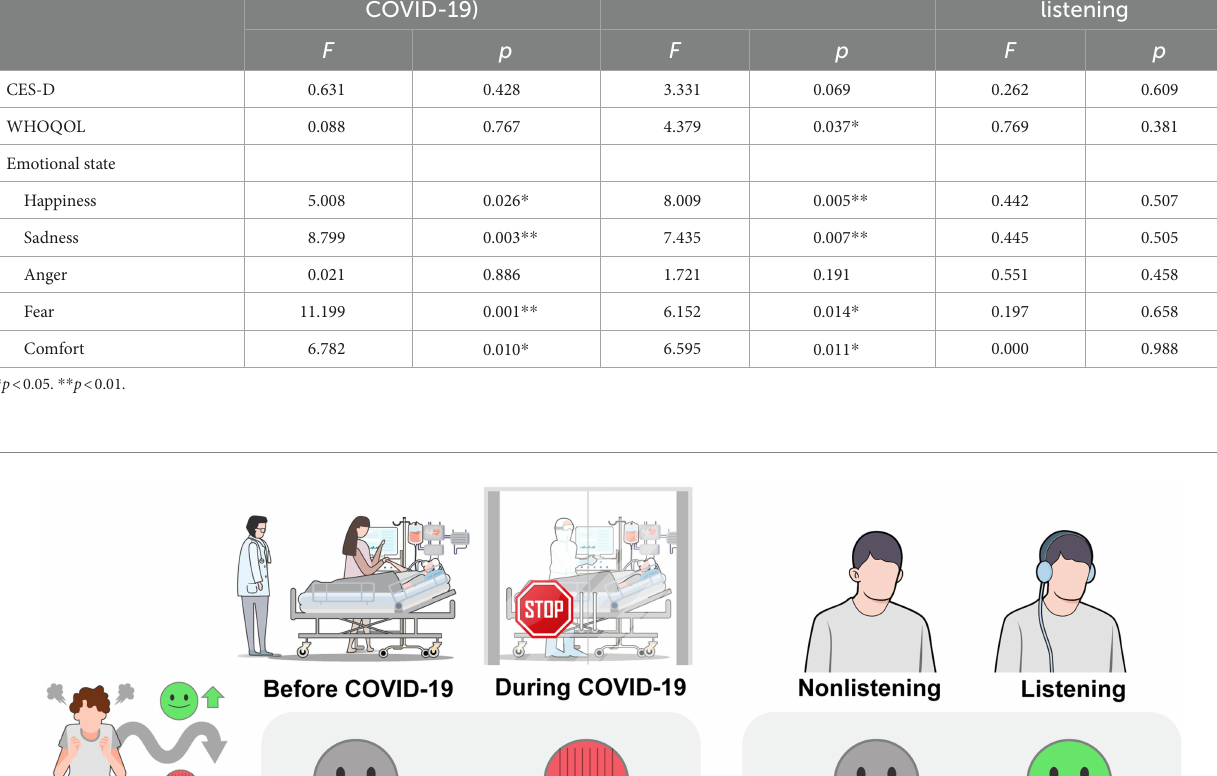
TABLE 4 Results of the two-way ANOVA for the effects of time point (before and during COVID-19) and music listening (yes vs. no). Variable Time point (before and during COVID-19)